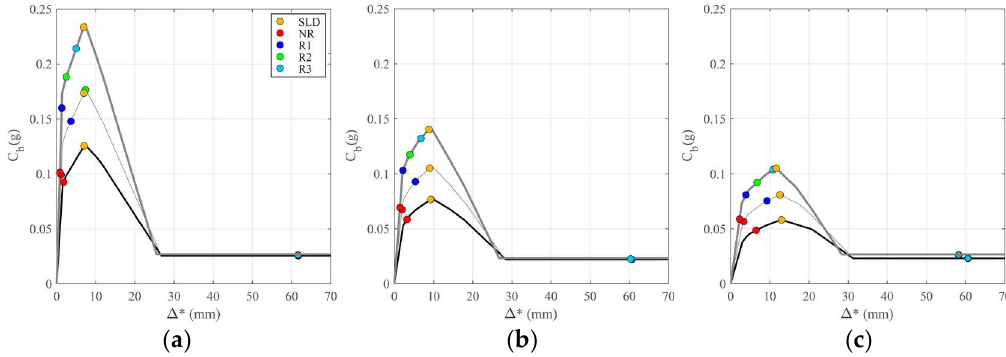
Figure 8. Capacity curves for the archetype buildings in transversal direction with mass proportional loads: ( a ) three-storey, ( b ) five-storey, and ( c ) seven-storey building with W (black), M (gray thin) and S (gray thick) infills. Limit states for no retrofit NR and increasing retrofit levels of FRP-only solution are represented along the curves.